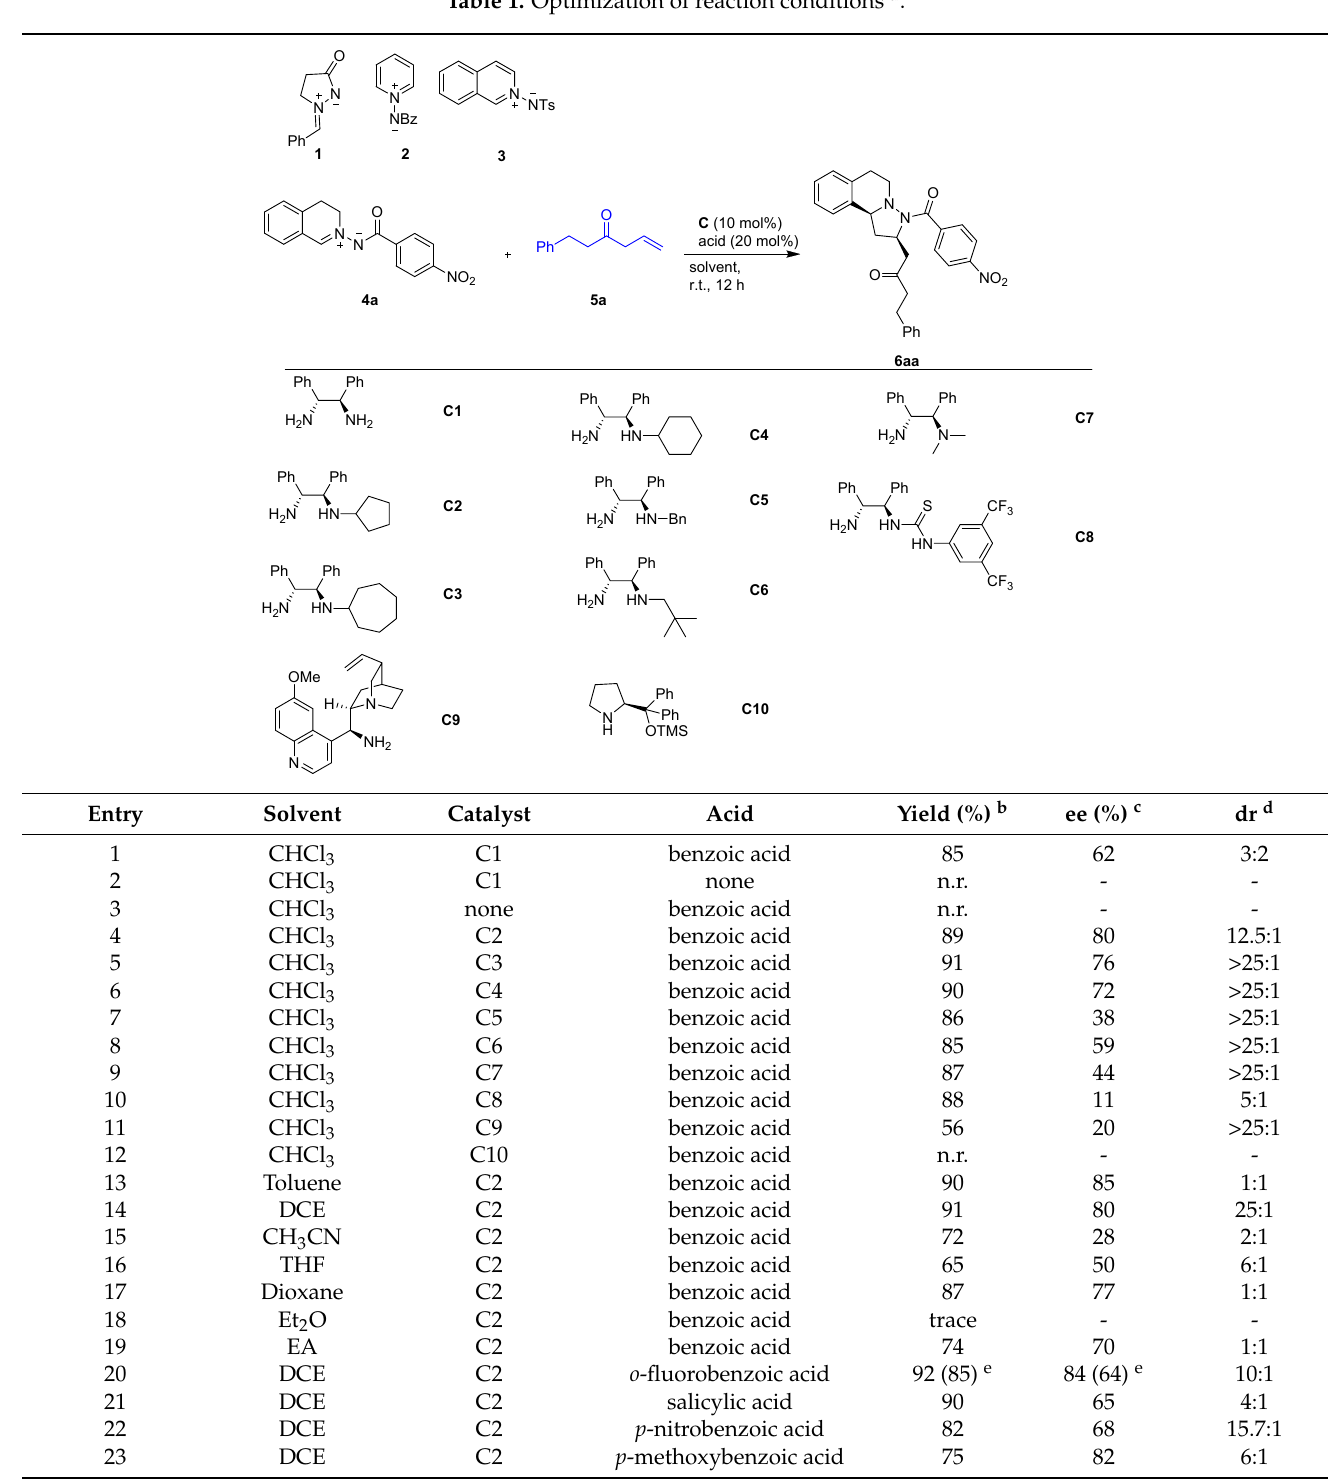
Table 1. Optimization of reaction conditions a .